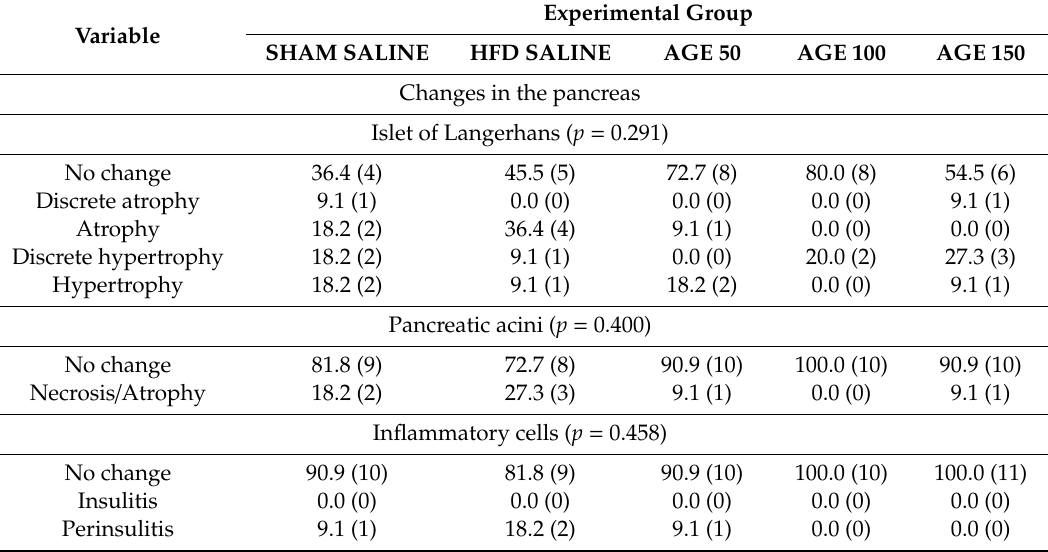
Table 5. Results for changes observed in the pancreas of the animals in each experimental